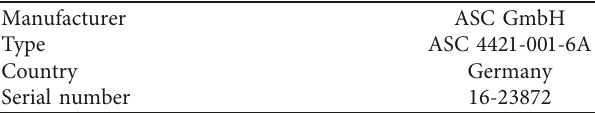
Table 6: Larger peak